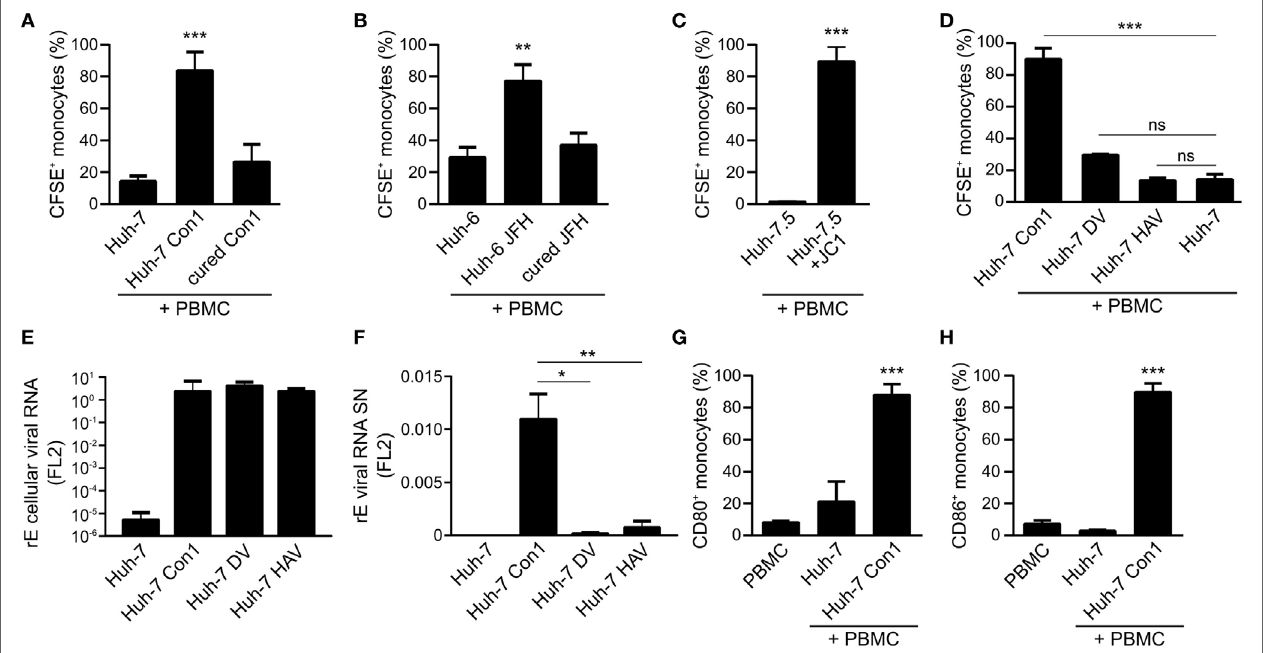
FigUre 3 | Phagocytosis of hepatitis C virus subgenomic replicon particles by monocytes is specific for HCV. (a–D) Peripheral blood mononuclear cells (PBMCs) were co-cultured with various carboxyfluorescein succinimidyl ester (CFSE)-stained Huh cells and the percentage of CFSE + monocytes was determined by flow cytometry. (a) Co-cultures of PBMCs with Huh-7 cells (Con1 = HCV genotype 1b) ( n = 3). (B) Co-cultures of PBMCs with Huh-6 cells (JFH = HCV genotype 2a) ( n = 3). (c) Co-cultures of PBMCs with Huh-7.5 cells or with HCV-infected Huh-7.5 cells (Huh-7.5 + JC1) ( n = 2). (D) Co-cultures of PBMCs with Huh-7 cells, Huh-7 Con1 (HCV), Huh-7 DV (dengue virus), or Huh-7 hepatitis A virus (HAV) SGR cells ( n = 3). (e,F) Huh-7 and Huh-7 SGR cells (Con1, DV, and HAV) were seeded for quantification of intracellular viral RNA (e) and secreted viral RNA in the supernatant (F) was measured by qPCR. RNA lysis buffer was spiked with Firefly Luciferase 2 (FL2) in vitro transcript for normalization ( n = 3). (g,h) Huh-7 cells were co-cultured with PBMCs overnight and monocytes were analyzed for activation by expression of CD80 and CD86 by flow cytometry ( n =